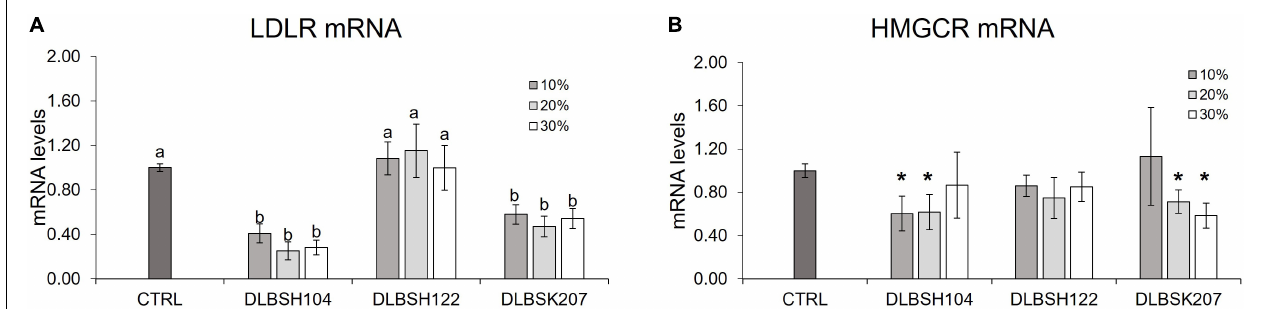
FIGURE 6 | Transcript levels of LDLR (A) and HMGCR (B) of HepG2 cells treated with CFS of potential Lactobacillus strains. HepG2 cells were treated with 10, 20, or 30% CFS of potential Lactobacillus strains and cholesterol (70 µ g/L) at 37 ◦ C for 20 h and then mRNA levels of LDLR and HMGCR was measured by RT-PCR. The result is expressed as mean ± SD of at least three independent experiments. One-way ANOVA or Student’s t -test was used and different letters (a, b) or * represents a significant difference with p -value < 0.05 compared to the